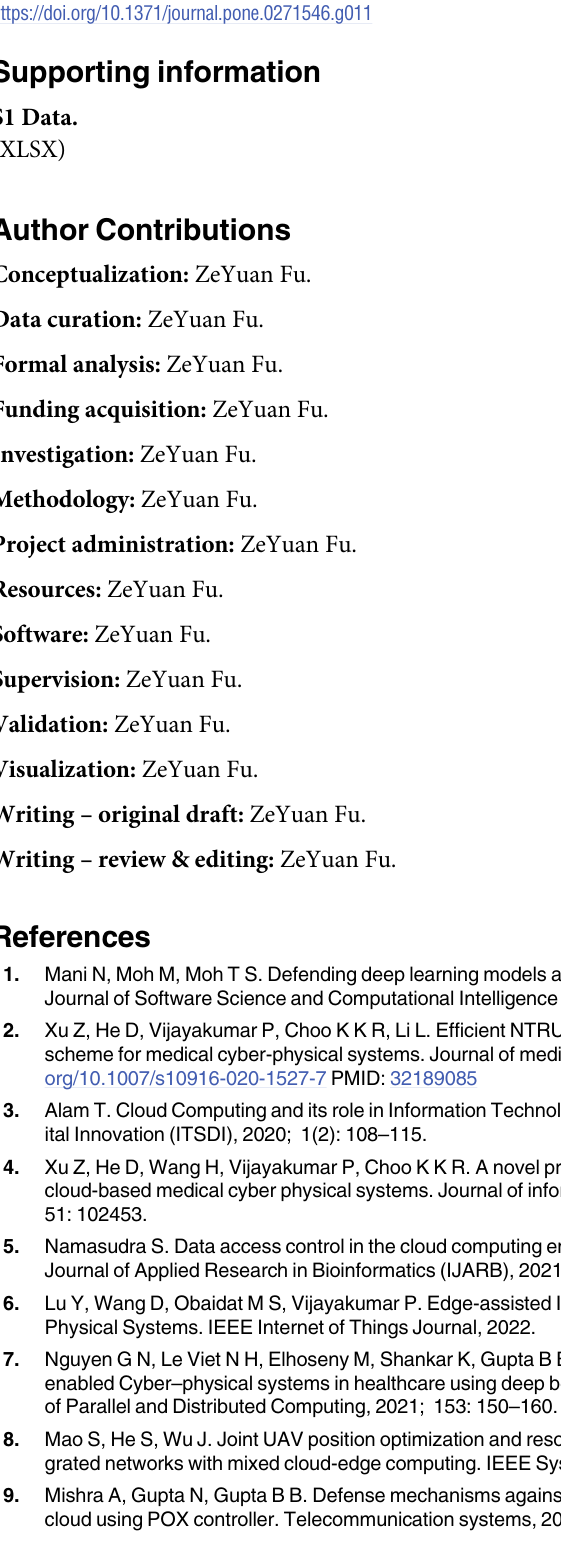
Fig 11. Comparison of encryption and decryption time (a. under fixed text size and key length; b. under different sizes of text with 1024-bit key; c. under different sizes of text with 2048-bit